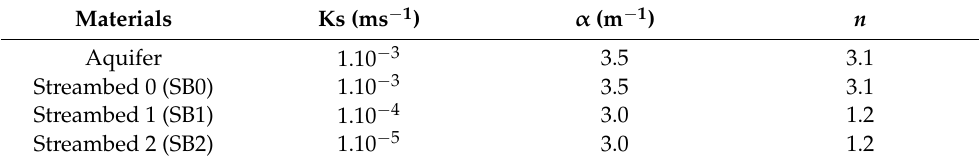
Table 1. Hydrodynamic parameters used in the numerical